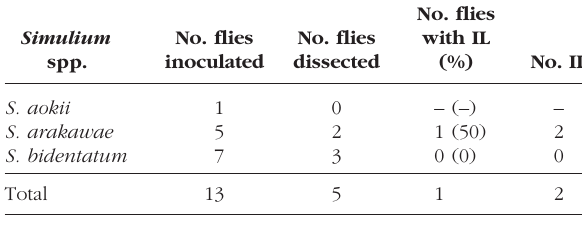
Table V. – Results of experimental infections of female Simulium species with Onchocerca lienalis.